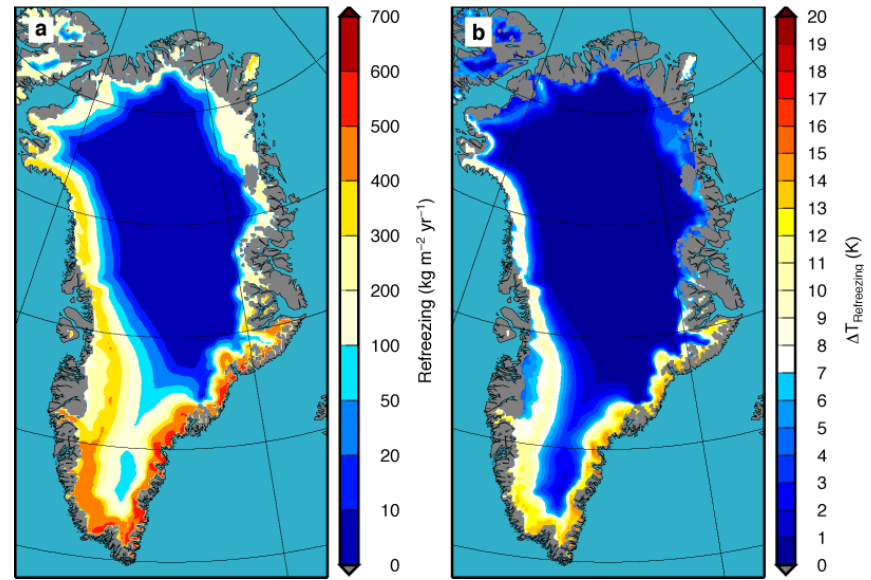
Fig. 6. (a) Refreezing in RACMO2/GR (Ettema et al., 2009) and (b) the increase in annual mean ice surface temperature due to this refreezing using the relation by Reeh (1991).